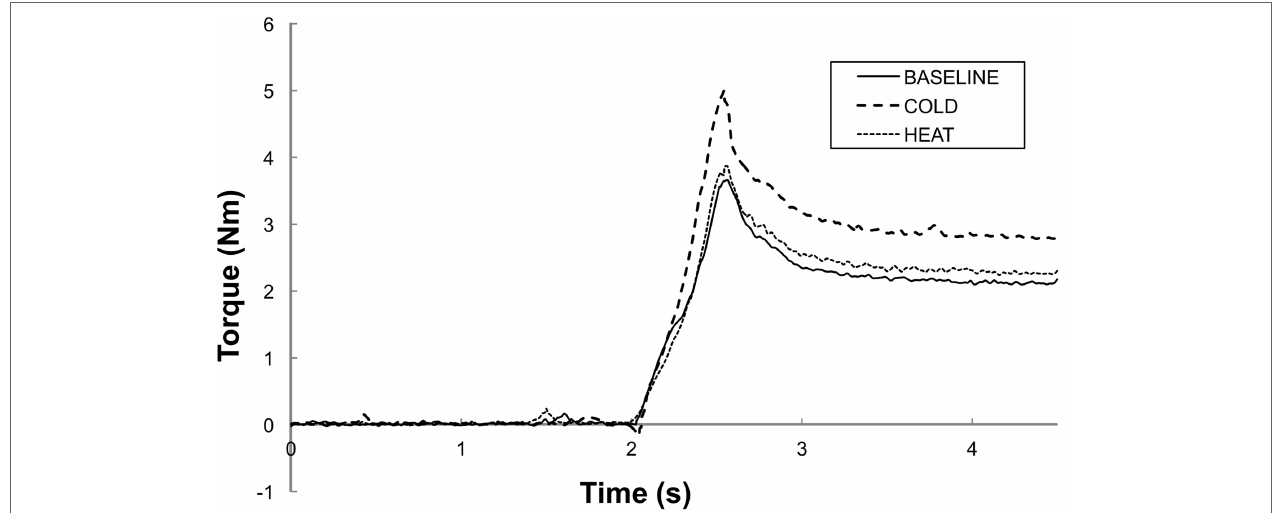
FigUre 2 | representative trials of total torque responses at a stretching speed of 100°/s . BASELINE: room temperature, COLD: 0°C cutaneous stimulation to the contralateral thenar eminence; HEAT: thermal stimulation at the heat pain threshold to the contralateral thenar eminence. Note that the peak torque response is greater in COLD as compared to in HEAT and BASELINE. Both HEAT and BASELINE have similar torque peak torque